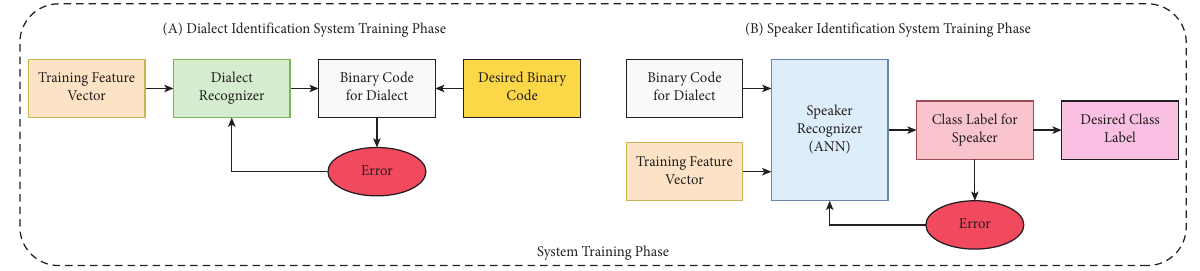
Figure 5: System training. (a) Training of dialect identification system. (b) Training of speaker identification system based on dialect information.